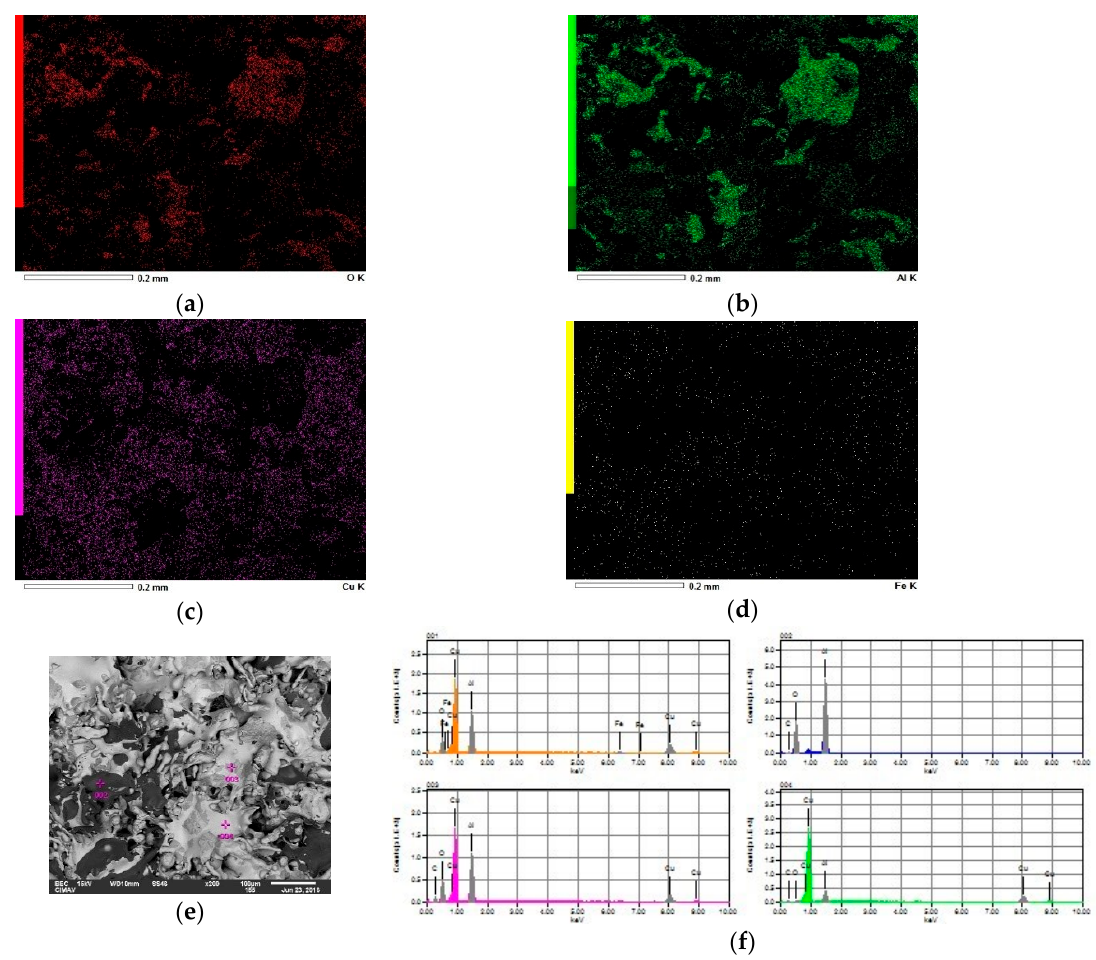
Figure 3. Chemical mapping of the surface coating at applied pressures of 359 kPa oxygen and 97 kPa acetylene: ( a ) EDS map of oxygen in red; ( b ) EDS map of aluminum in green; ( c ) EDS map of copper in violet; ( d ) EDS map of iron in yellow; ( e ) SEM micrograph of the surface; ( f ) EDS spectrum.